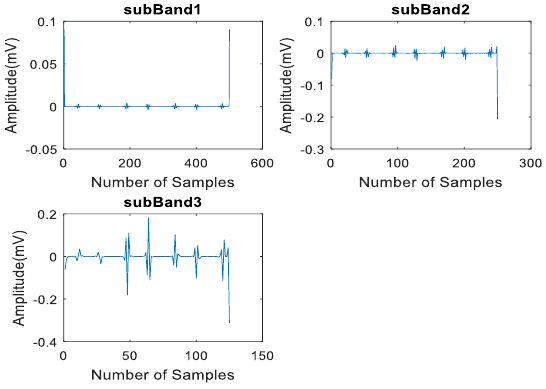
Fig. 6. The sub bands of the ECG signal for Tree B.